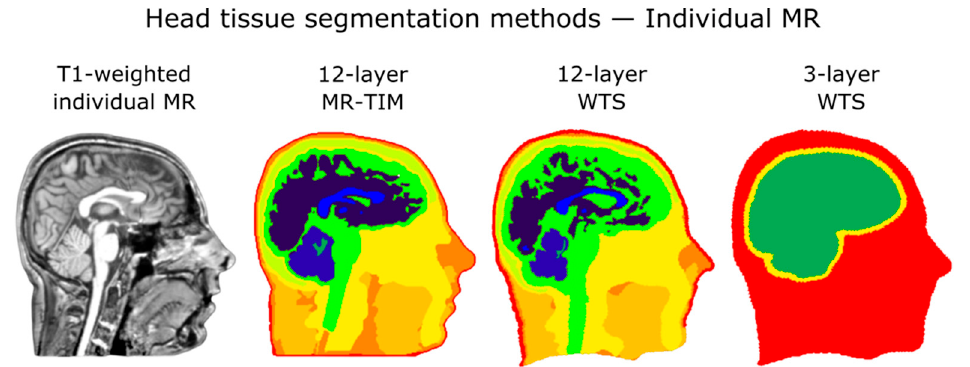
Figure 3. Example of head tissue segmentations used in the study. From left to right: T1-weighted individual MR image; 12-layer segmentation using the MR-TIM toolbox; 12-layer segmentation using WTS; 3-layer segmentation using WTS.